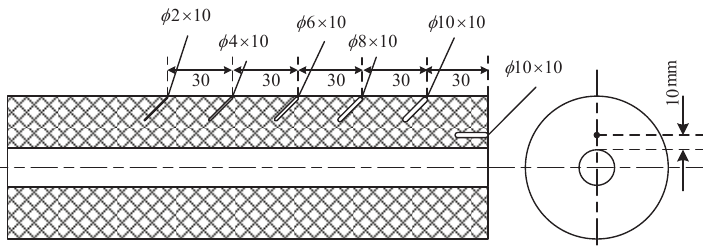
Figure 10. Sizes and distribution of artificial defects (the holes are defined as diameter × depth with all units in mm).